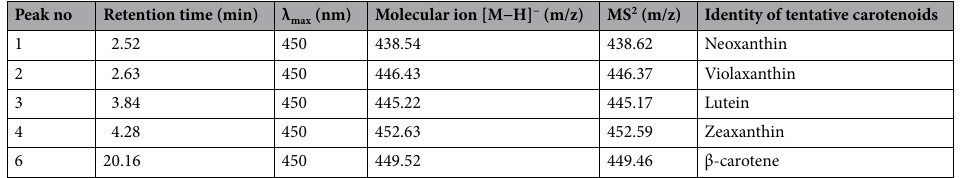
Table 2. Retention time, wavelengths of maximum absorption in the visible region (λ max ), mass spectral data and tentative identification of carotenoid profiles in four selected A. gangeticus leafy vegetables.